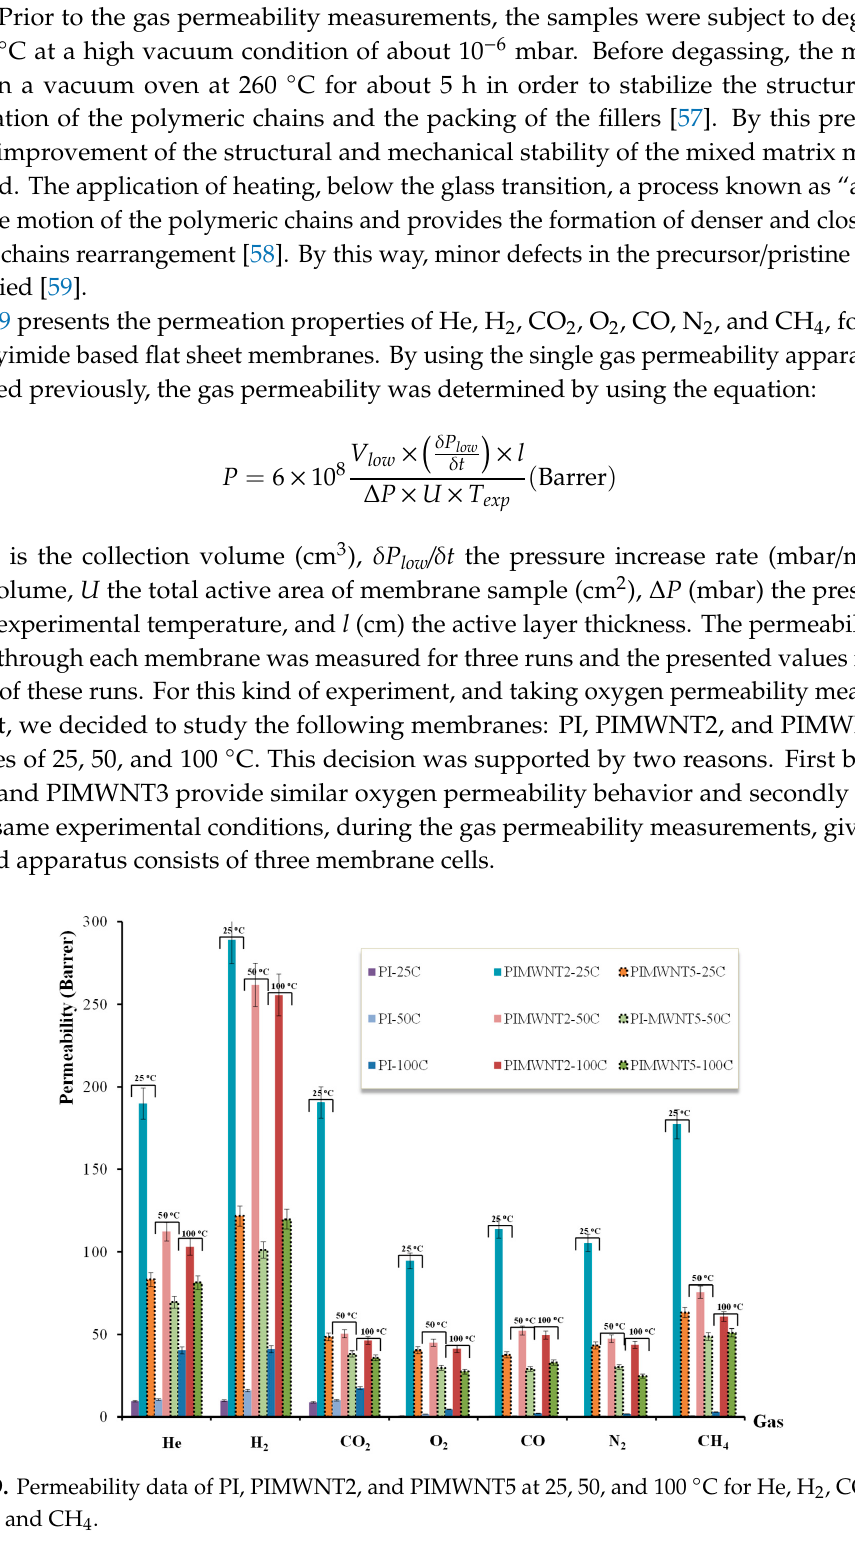
Table 5. Gas permeability values at different at different temperatures.